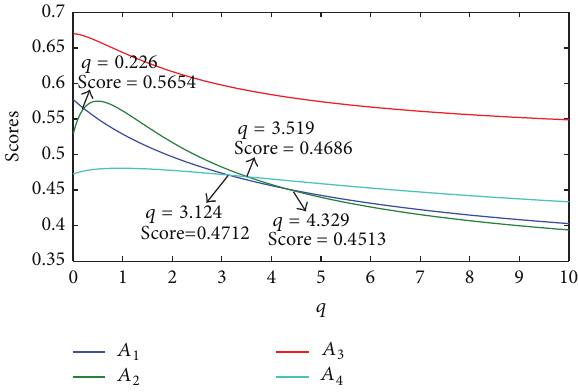
Figure 3: Scores of IIFWGHM ( 𝑝 = 1, 𝑞 ∈ (0, 10]